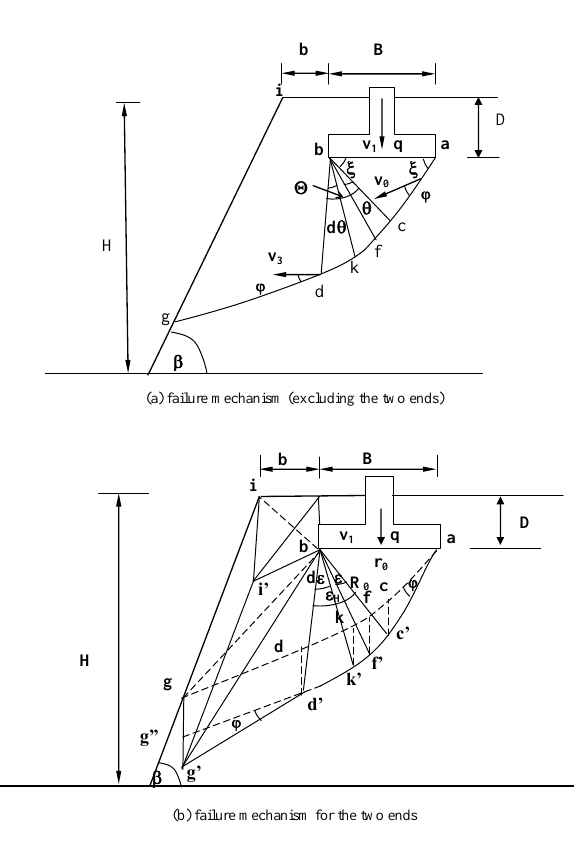
Figure 2. Three-dimensional failure mechanism for slope with buried patch